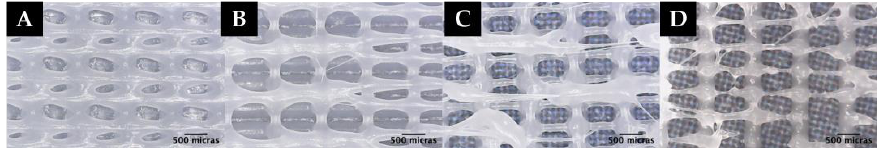
Figure 6. Microscopy images of experiment: ( A ) F1B, ( B ) F2B, ( C ) F3B, ( D ) F4B. As shown in Figure 6, when printing at a speed of 600 mm/min (10.0 mm/s) and an extrusion multiplier value of 1.0, no microfiber formation was observed. As the extrusion volume is decreased (0.60), random microfiber formation begins to be observed. It was also noticed that when making prints with the fan switched off, it takes up to 5 min for PCL to dry at room temperature. This is due to its low melting point.